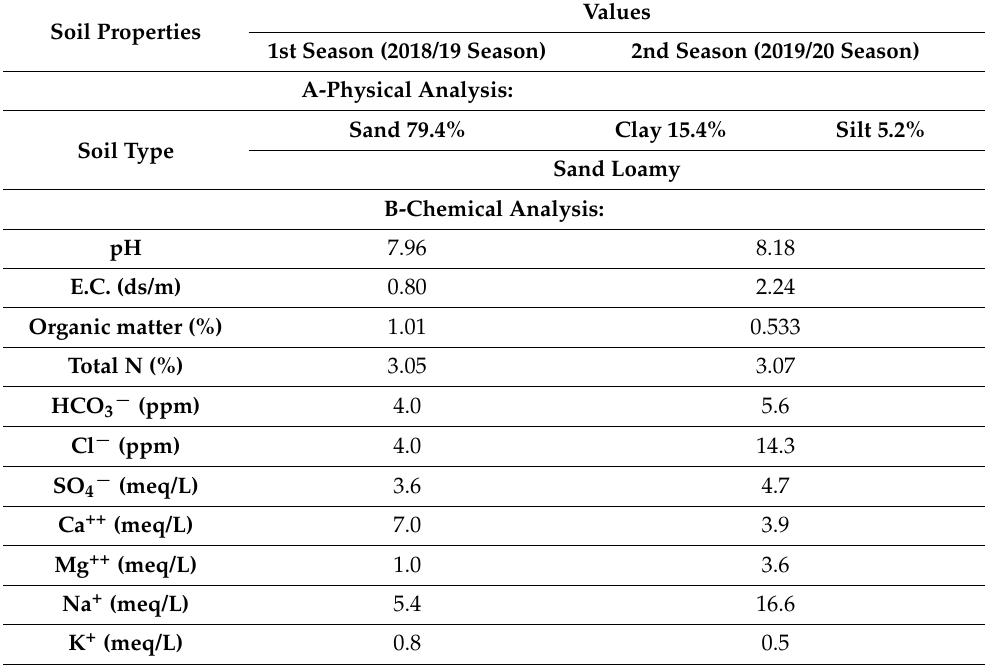
Table 1. Physical and chemical soil properties at the experimental site, for the two experimental seasons. Soil